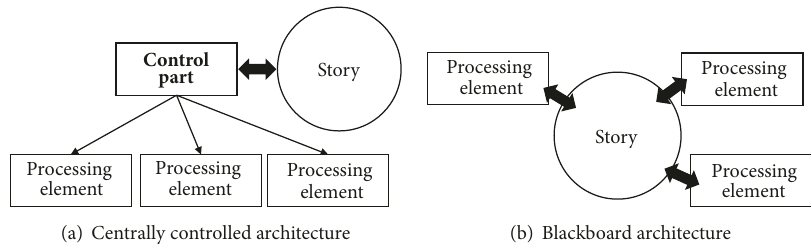
Figure 7: A centrally controlled architecture and a blackboard